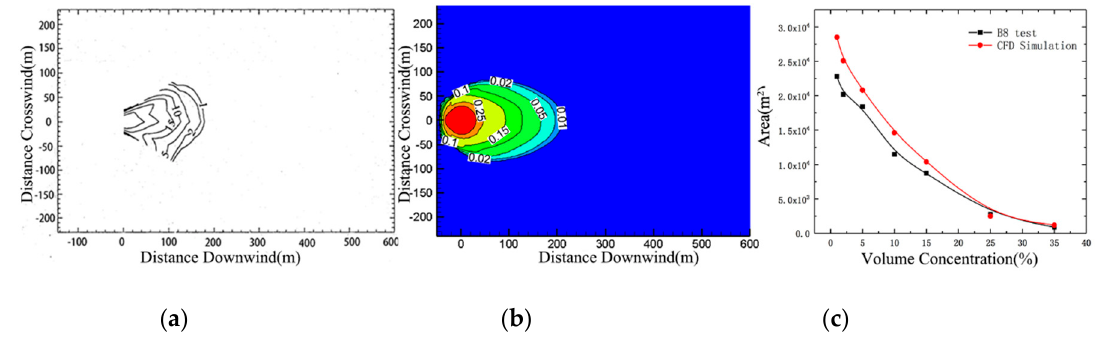
Figure 3. Comparison of experimental and simulated values of methane volume concentration at a vertical height of 1 m. ( a ) Burro eight-test measured value. ( b ) Fluent simulation results. ( c ) Comparison of test and simulation.